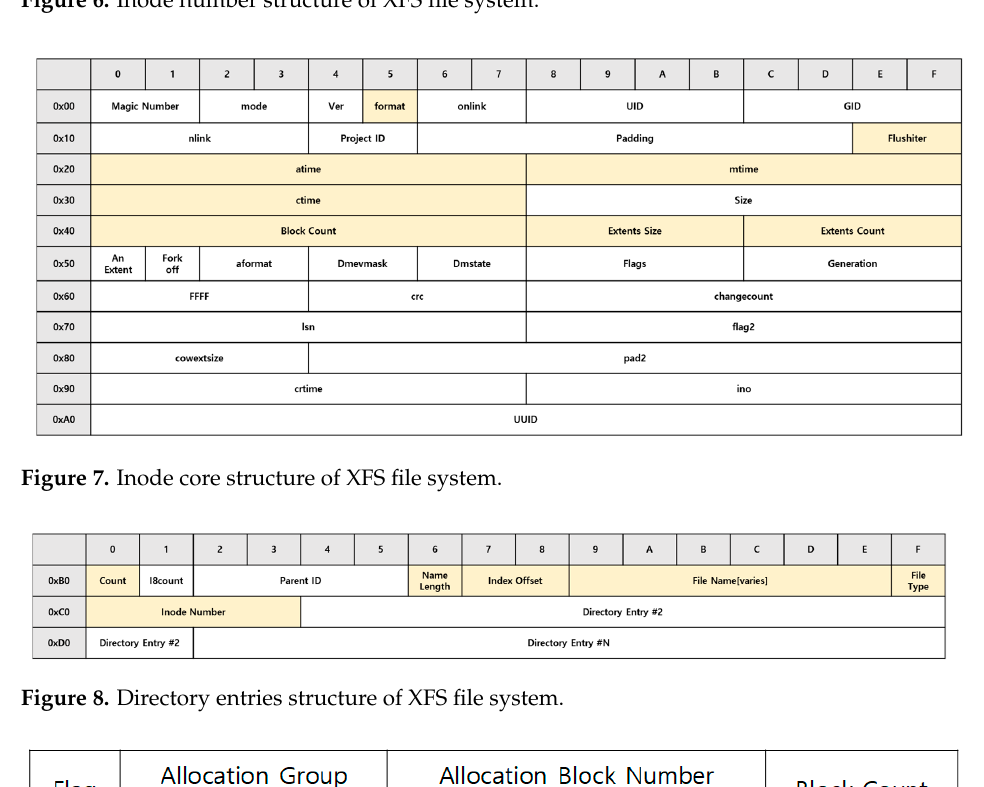
Figure 7. Inode core structure of XFS file system.